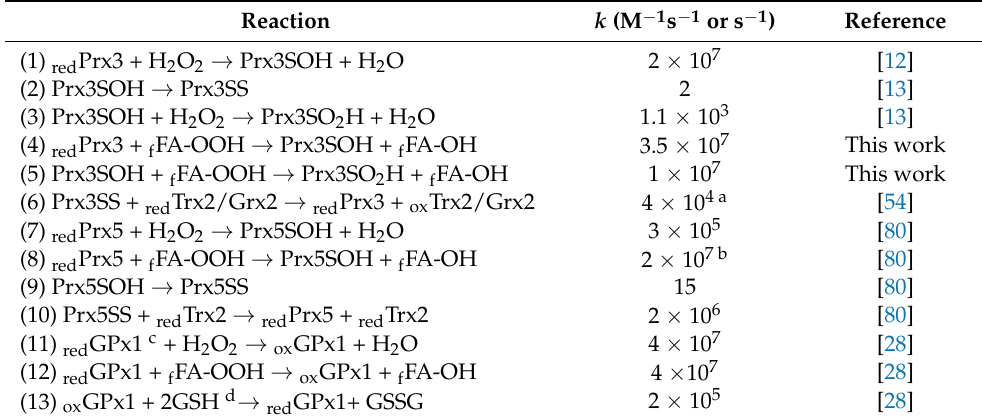
Table 4. Rate constants and concentrations used in simulations of expected yields of Hs Prx3 hyperoxidation.